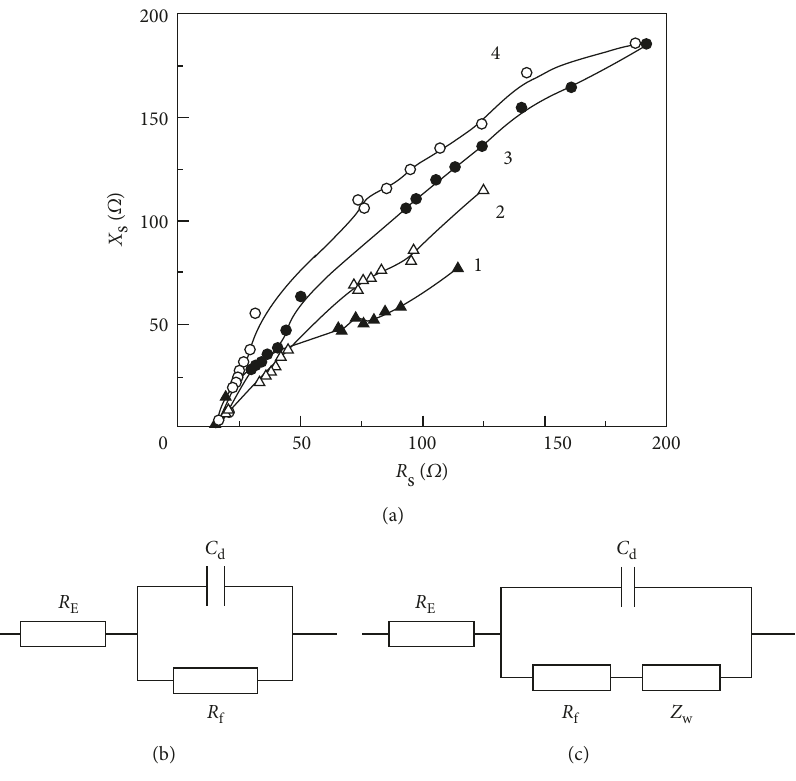
Figure 11: Nyquist plots (a) of mixed-oxide systems: 1: TiO equivalent substitution schemes for systems TiO